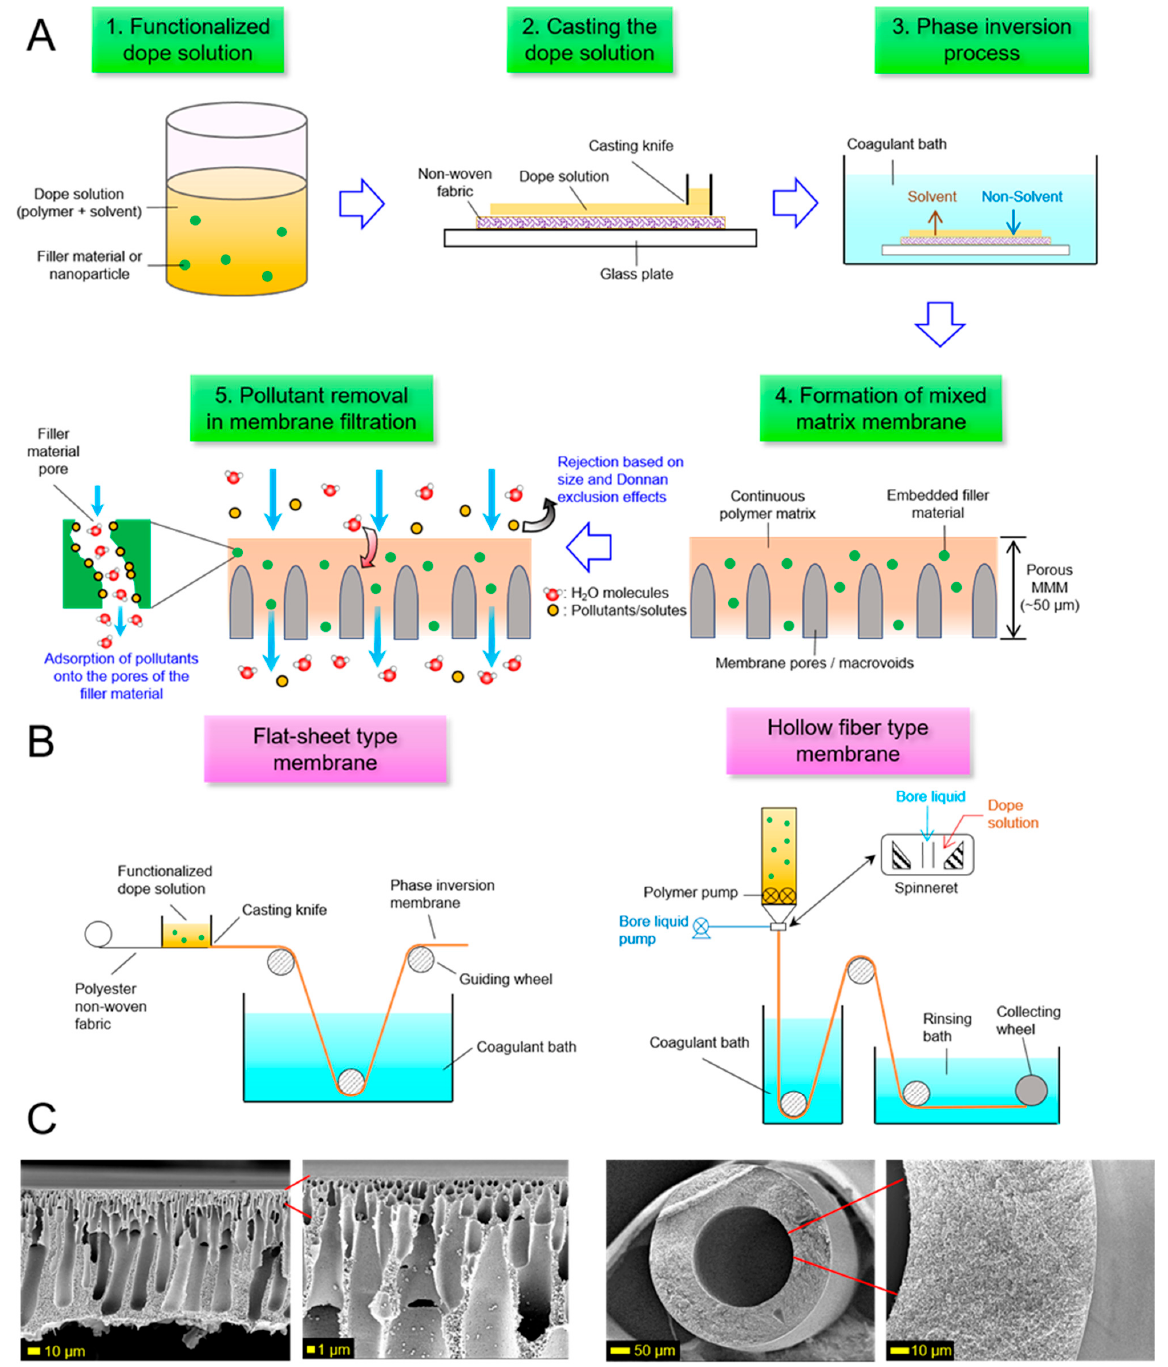
Figure 2. ( A ) Schematic illustration of the methodology to fabricate porous MMMs via the phase inversion process in a lab-based setting. The filler materials are embedded into the continuous polymer matrix. The pollutant rejection and removal mechanisms are the size exclusion and Donnan exclusion effect by the membrane as well as the adsorption of pollutant ions onto the inner pores of the filler material. ( B ) Schematic illustration of the large-scale production of flat sheet and hollow fiber type MMM via membrane casting (left) and spinning technique (right). ( C ) Scanning electron microscopy (SEM) images of porous membranes. The left-most two images outline a flat-sheet Polysulfone (PSf) membrane that is dominated by tiny macrovoids at the top and big macrovoids at the bottom. The right-most two images outline a hollow fiber Matrimid 5218 (Polyimide) membrane that has a fully sponge-like structure. All SEM images were taken at an operating voltage of 5.0 kV.